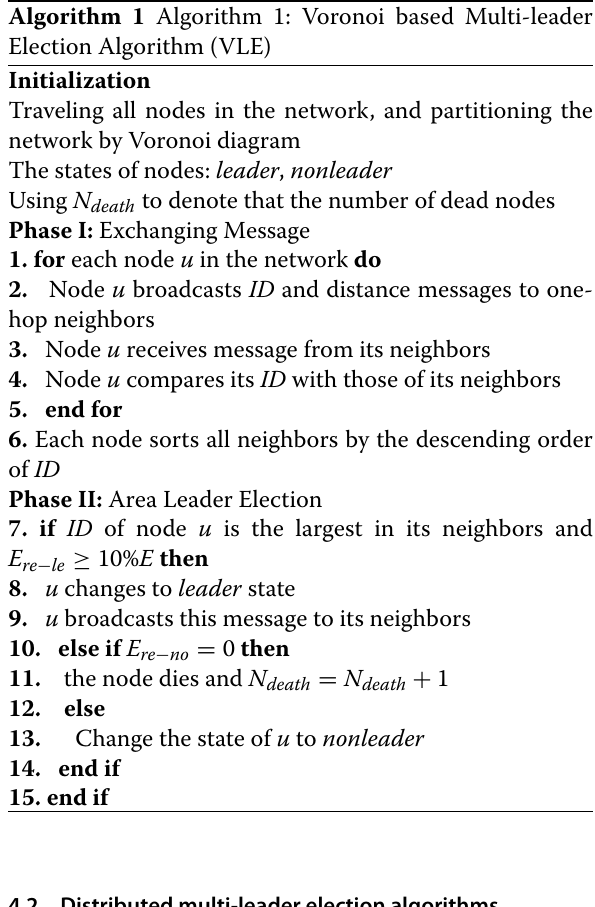
Algorithm 2 is a distributed leader election